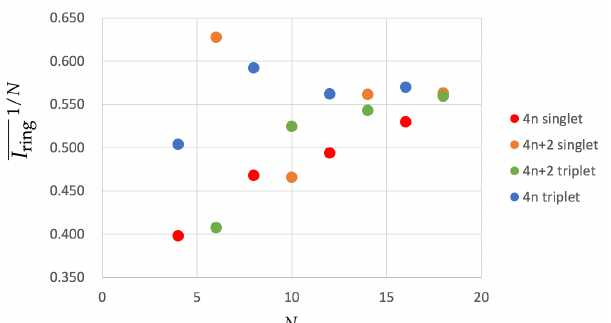
Figure 3. Values of I ring 1/ N for the annulenes series in terms of the number of C atoms ( N ) for the lowest-lying singlets and triplets. The species have been divided according to the number of electrons (4 n and 4 n + 2) and the spin multiplicity (singlet and triplet). Calculations were performed with CAM-B3LYP/6-311G(d,p).